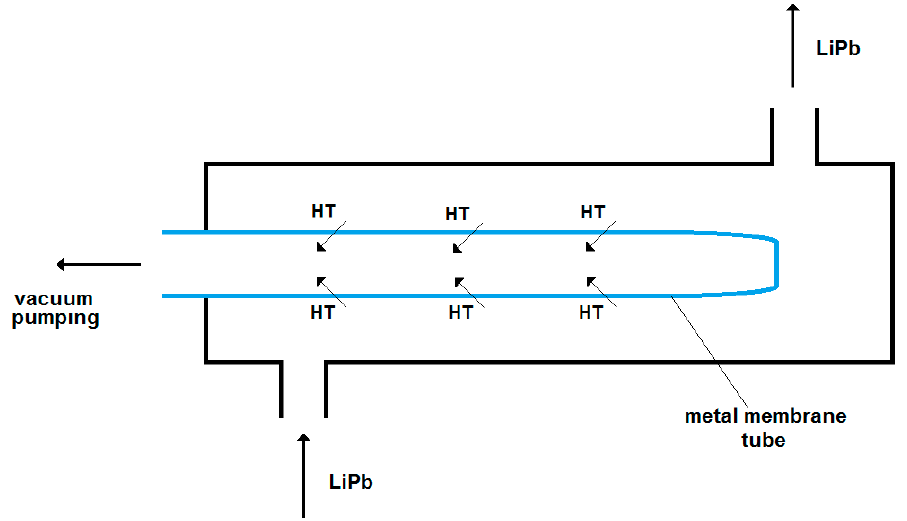
Figure 3. Schematic of the Permeation Against Vacuum (PAV) concept.